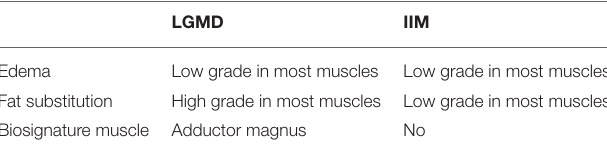
TABLE 5 | The brief summary of the imaging characteristics in the patients with limb-girdle muscular dystrophy and idiopathic inflammatory